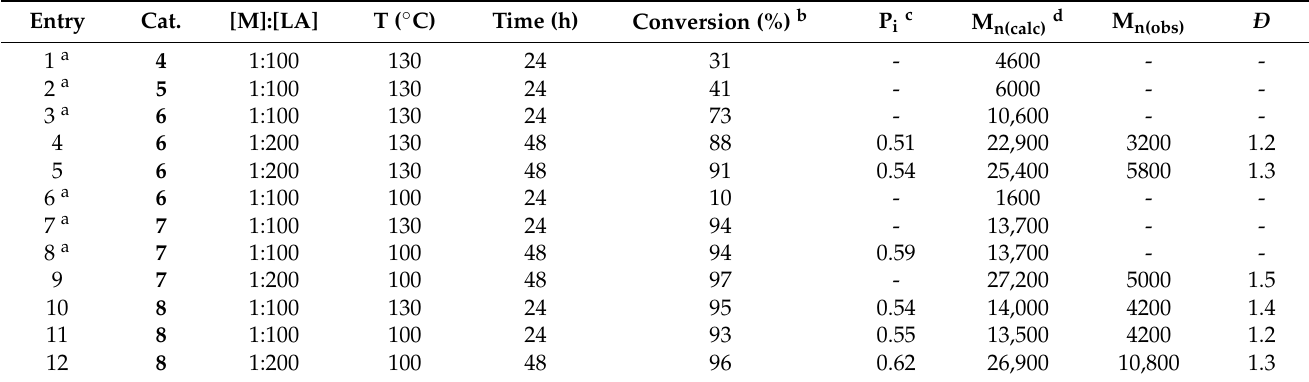
Table 1. rac -lactide polymerisation data for complexes 4–8 .